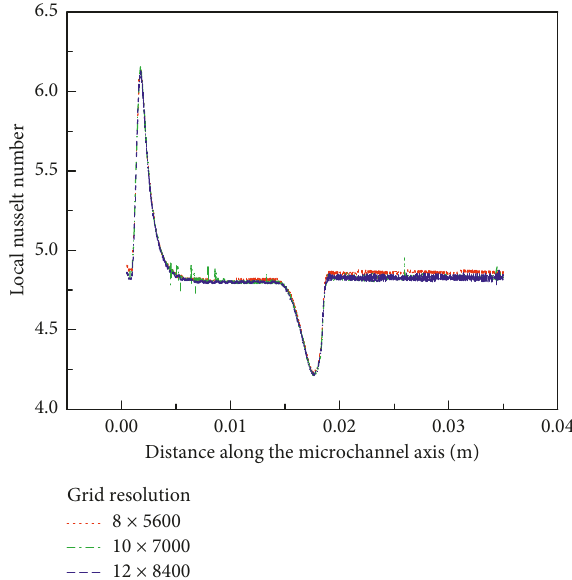
Figure 2: Local Nusselt number variations along the microchannel axis for different mesh resolutions.